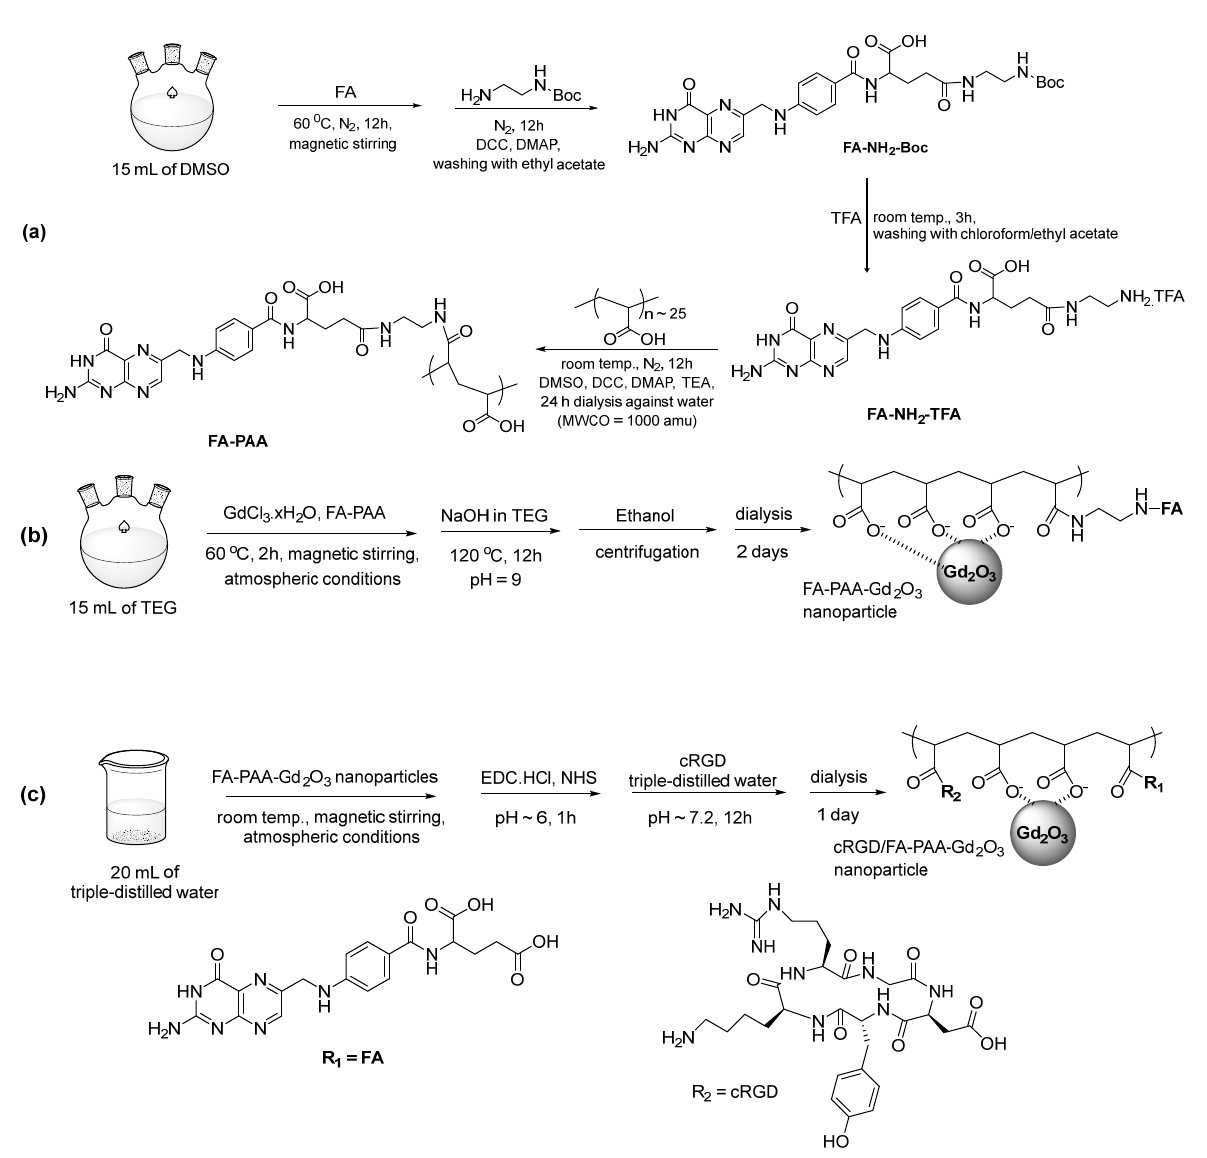
Figure 1. ( a ) Synthesis of FA-PA, ( b ) one-pot polyol synthesis of FA-PAA-Gd 2 O 3 nanoparticles, and ( c ) synthesis of cRGD/FA-PAA-Gd 2 O 3 nanoparticles. FA-PAA-Gd 2 O 3 nanoparticles were obtained using a one-pot polyol method (Figure 1b). Briefly, a mixture of 2.0 mmol GdCl 3 ∙ 6H 2 O, 0.3 mmol of the above-synthesized FA-